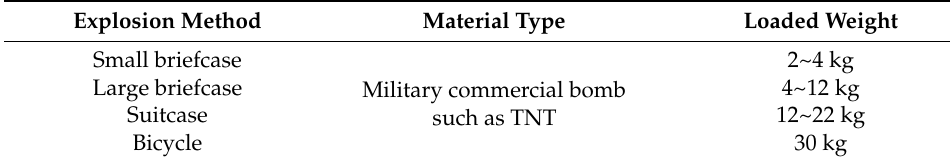
Table 2. Typical example of terrorist explosive materials [63].